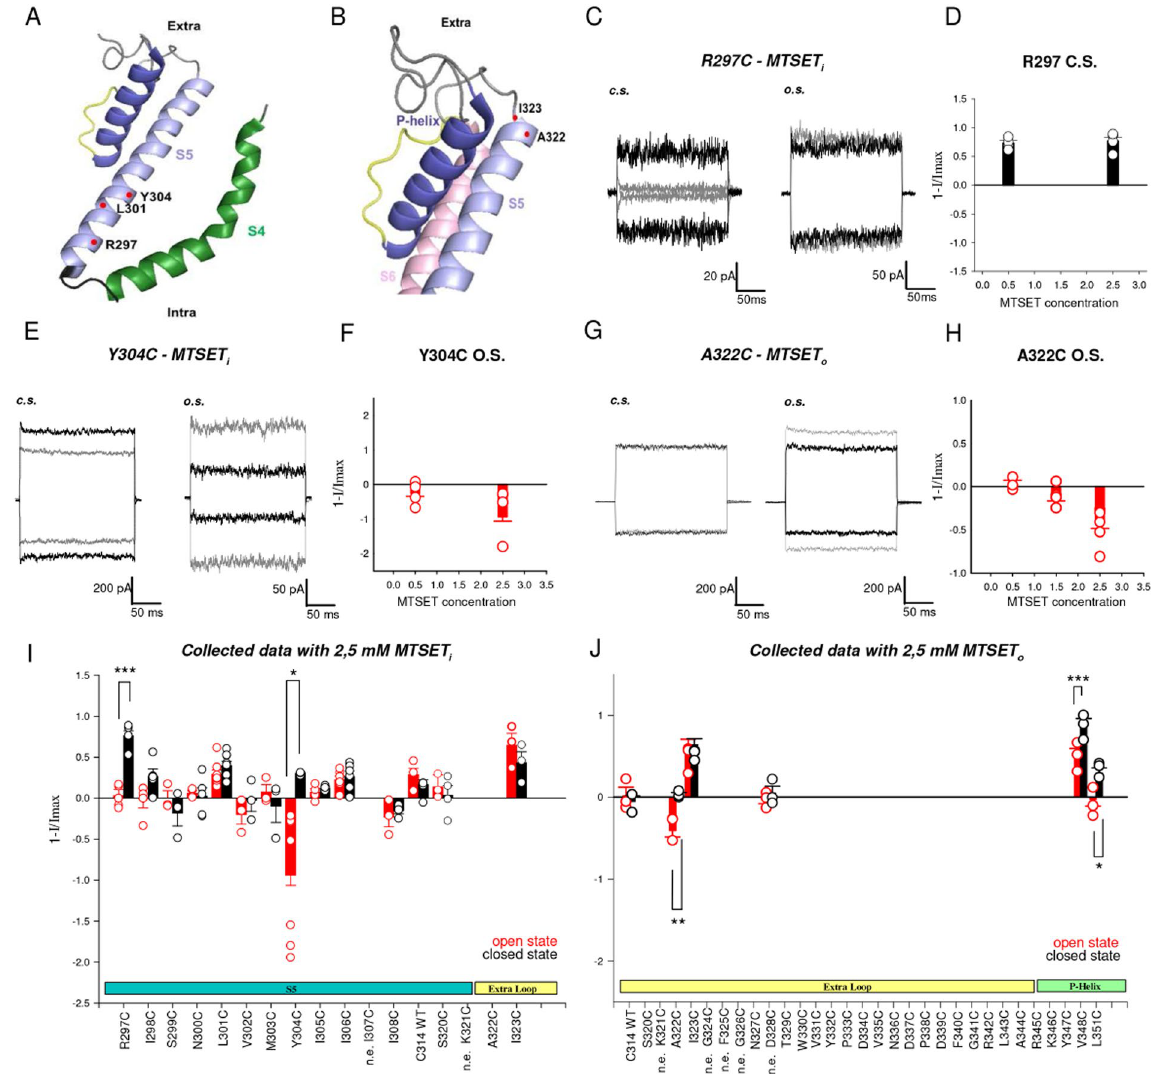
Figure 4. Cysteine scanning mutagenesis shows a state dependent accessibility of S5. ( A ) Mapping CNGA1 residues on TAX-4 structure (PDB ID: 5H3O) shows the location of key residues in the intracellular portion of S5. ( B ) as in ( A ) but for extracellular portion of S5. Key residues are highlighted with red spheres. Different regions (S4–S5 and P-helix) are illustrated in different colours. ( C ) Comparison between the cGMP-activated currents at ± 60 mV for the mutant channels R297C before (black) and after (grey) 3 minutes application of 2.5 mM MTSET to the intracellular side ( MTSET i ) in the closed (c.s.) and open (o.s.) states. ( D ) Plot representing the comparison of MTSET i at different concentration (n = 4 for 0.5 mM and n = 5 for 2.5 mM) in the closed state for mutant channels R297C; histograms are the average ± s.e.m. and circles indicate data from single experiments. ( E ) as in ( C ) but for the mutant channels Y304C. ( F ) as in ( D ) but for the mutant channels Y304C in the open state (n = 4 for 0.5 mM and n = 7 for 2.5 mM). ( G , H ) as in ( E ) and ( F ) but for the mutant channels A322C with the addition of 2.5 mM MTSET to the extracellular side ( MTSET o ) and with different concentration of MTSET (n = 3 for 0.5 mM, n = 4 for 1.5 mM and n = 7 for 2.5 mM). ( I , J ) Histograms representing the average ± s.e.m. for many mutant channels, circles indicate data from single experiments after the application of 2.5 mM MTSET in the open (red) and closed (black) states. The number (n) of experiments for different mutant channels in different states varies between 3 and 8 (see also Supplementary Table 2). (n.e.) represents mutant channels without expression. Significativity is shown only for mutants where the MTSET effect was > 30%. Unpaired two–tail T-test in i for R297C and Y304C: t 7 = − 7,529, P < 0.001; t 8 = − 2,649; P < 0.05. Unpaired two–tail T-test in j for A322C, V348C and L351C: t 8 = − 3,668, P < 0.01; t 12 = − 4,544, P < 0.001; t 6 = − 3,109, P < 0.05. Further statistical tests for these mutant channels and for all other tested mutants are reported in Supplementary Table 2c,d. 1-I/Imax represents the normalized current where I is the residual current measured in the presence of 1 mM cGMP after application of MTSET (in different conditions) and Imax is the cGMP-activated current at the beginning of the